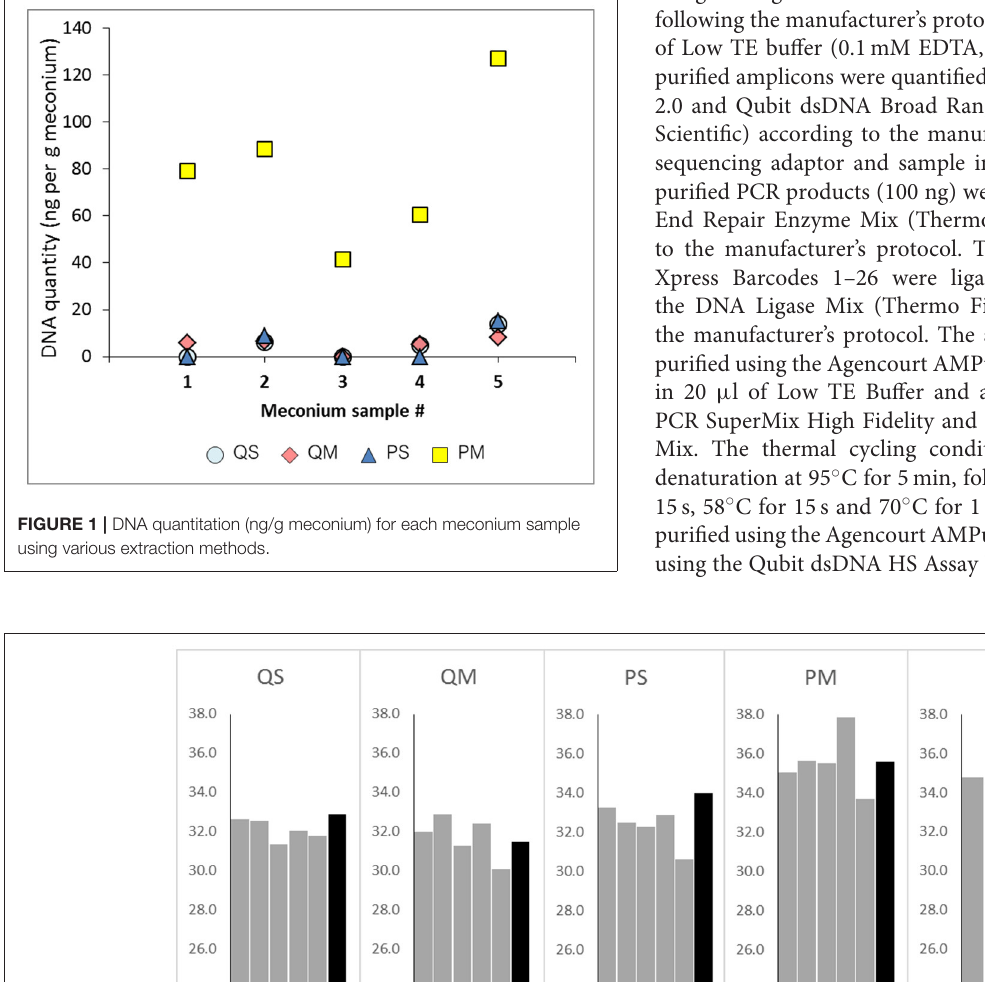
Frontiers in Microbiology |